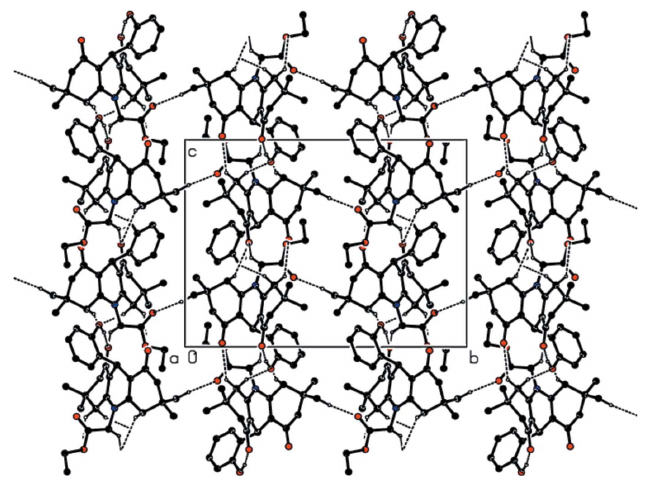
Figure 1 The title molecule with displacement ellipsoids drawn at the 30% probability level. Only the major disorder components for O3 and C17 are